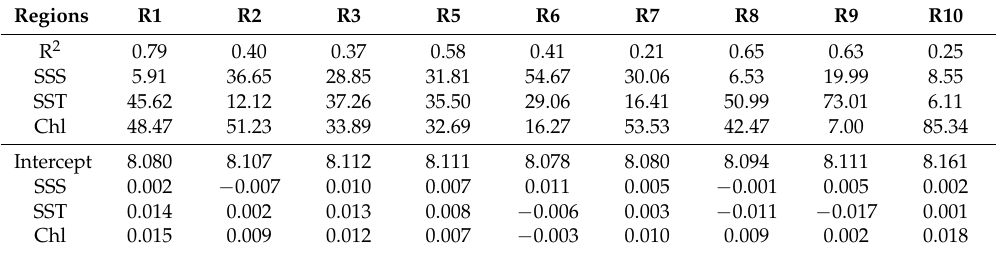
Table 2. Results of the multi-linear regression analysis using SSS, SST and Chl variables with the underway data divided into 11 regions. The R 2 values express how much of the pH variance is explained by the regression. The component of the pH variance that can be attributed to each variable is expressed in percentage. The SSS, SST amd Chl values in the lower part of the panel detail the equation coefficients of each parameter used to describe pH. Irish Sea (region 1), Malin Sea; northwest of Ireland (region 2), Celtic Sea (region 3), south of Cornwall, UK (region 4), Bay of Biscay (region 5), English Channel (region 6), Southern North Sea (region 7), Central North Sea (region 8), Skagerrak (region 9), Northern North Sea (region